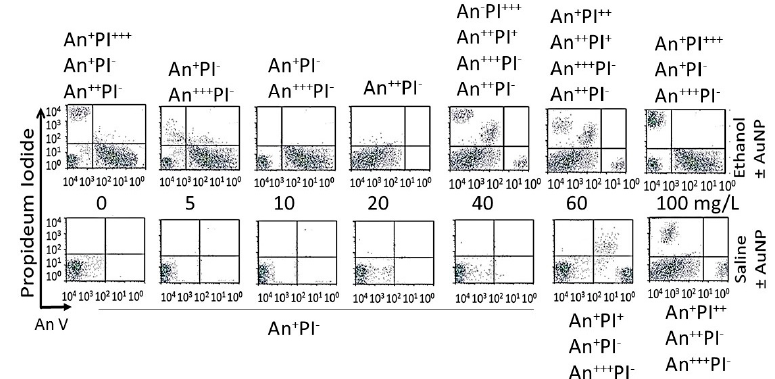
Figure 12. Effects of different doses of AuNPs on incorporation of annexin V and propidium iodide (PI) in An/En (bottom 0 mg/L), Ap/En (bottom 5 to 100 mg/L), Ap/Ep (top 5 to 100 mg/L AuNP) and An/Ep (top 0 mg/L) cells. Superscripts + to +++ represent relative distribution of An and/or PI positive cells ( − : An negative, + : lowest distribution, ++ : intermediate distribution and +++ : high distribution). Table 2. Effects of AuNP dose on SH-SY5Y cell phenotype.